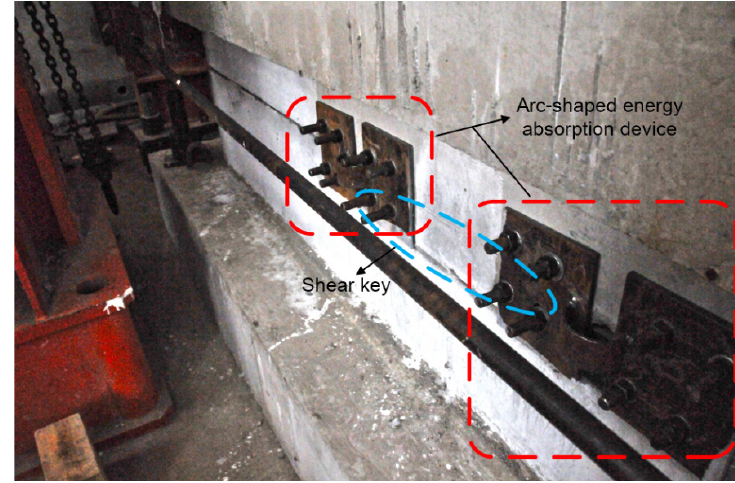
Figure 7. Assembled specimen.